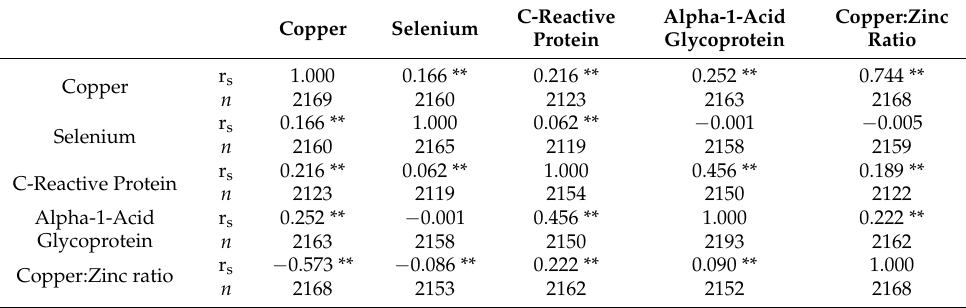
Table 8. Spearman correlation coefficient between plasma copper and selenium concentrations and inflammatory